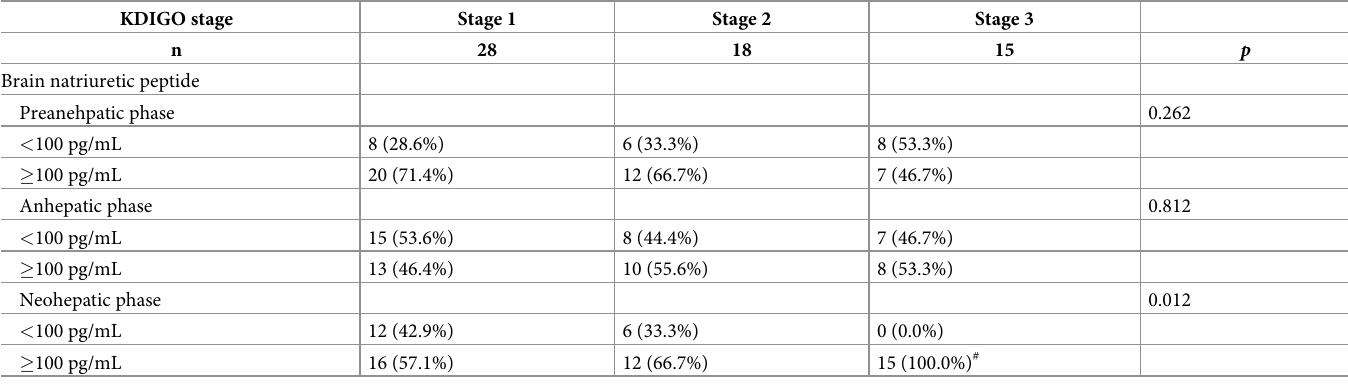
Table 6. Incidences of high serum levels of brain natriuretic peptide ( � 100 pg/mL) according to KDIGO stage during living donor liver transplantation.